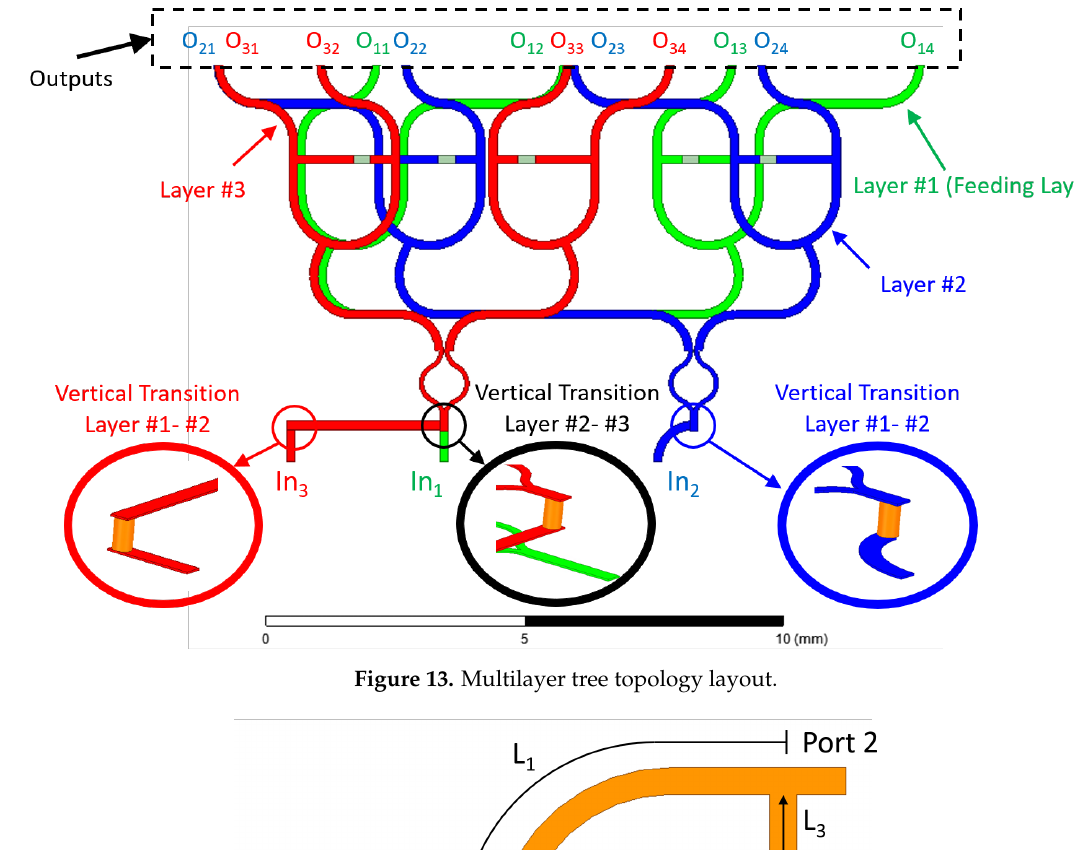
Figure 13. Multilayer tree topology layout.